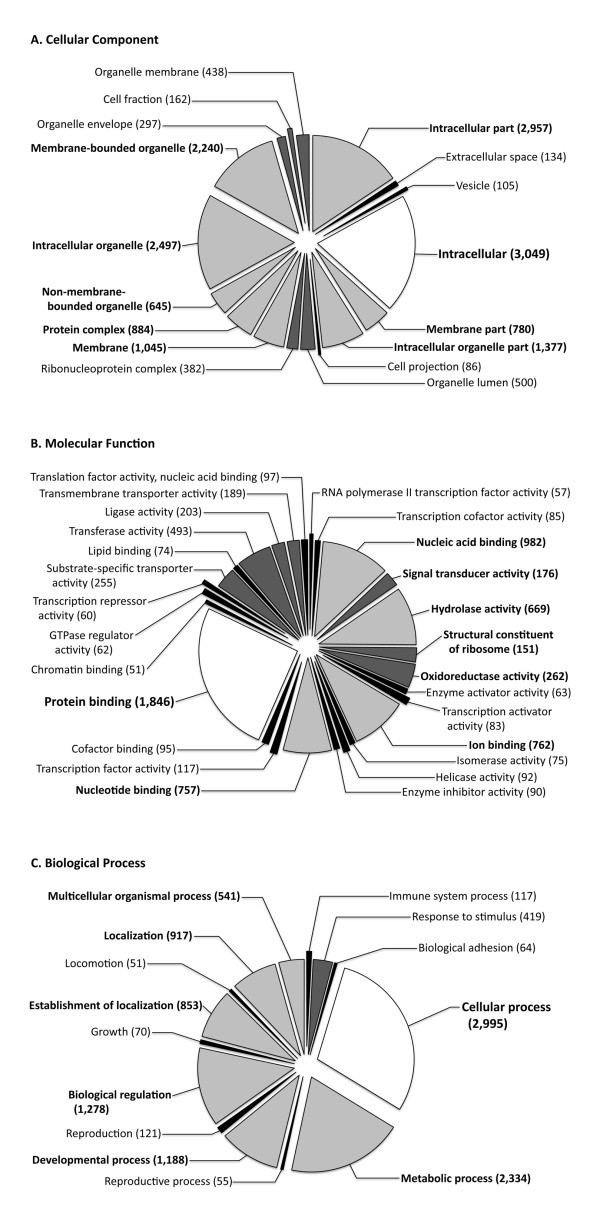
Gene ontology graph of A. Cellular Component (3rd level GO terms), B. Molecular Function (3rd level GO terms), and C. Biological Process (2nd level GO terms) of annotated genes in the striped bass ovary transcriptome. The number of GOs in each class is shown and sections that contained 50-150 entities are represented in black, 151-500 by dark gray, 500 and up by light gray, and the predominant class is indicated in white.